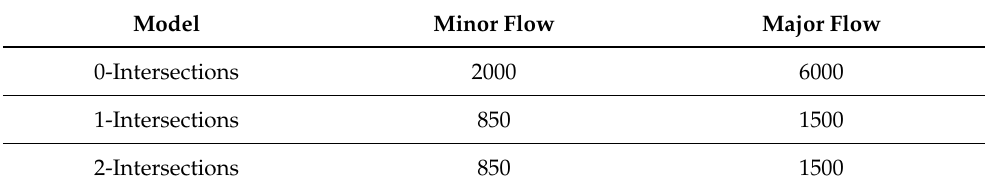
Table 1. Amount of minor and major flow in veh/h for each